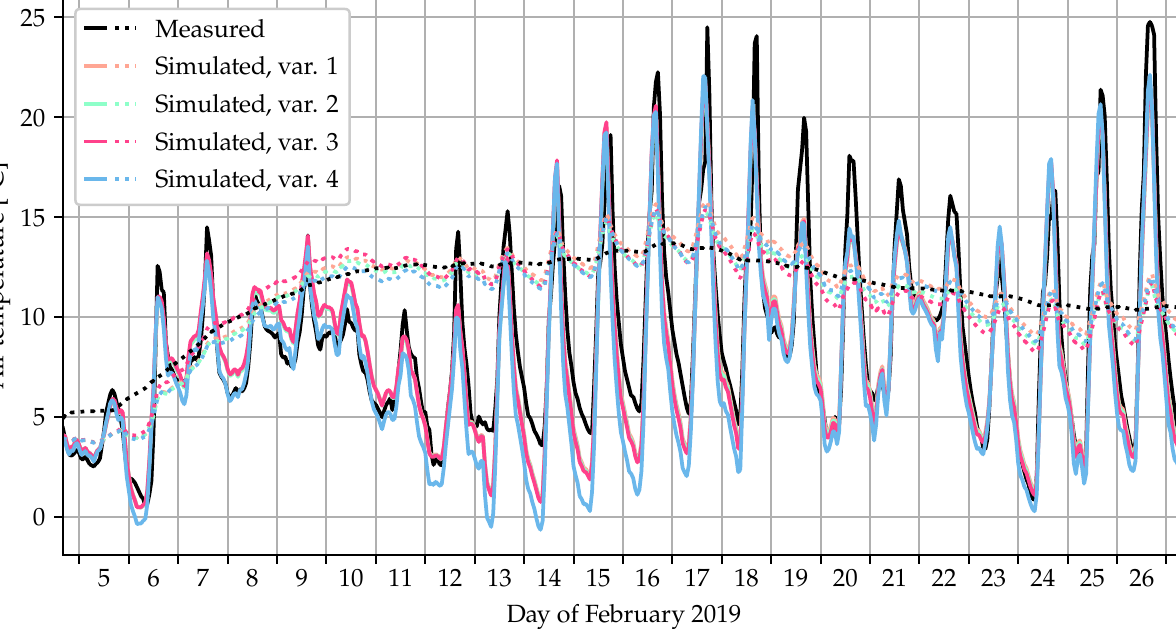
Figure 6. Mean air temperatures of the unheated zones of the case study building (solid lines: attic, dotted lines: basement) during the measurement campaign in February 2019, measured and simulated using model variations 1 to 4 (see Section 2.4). Simulated attic temperatures of variations 1 to 3 largely agree, causing the line for variation 3 to cover the